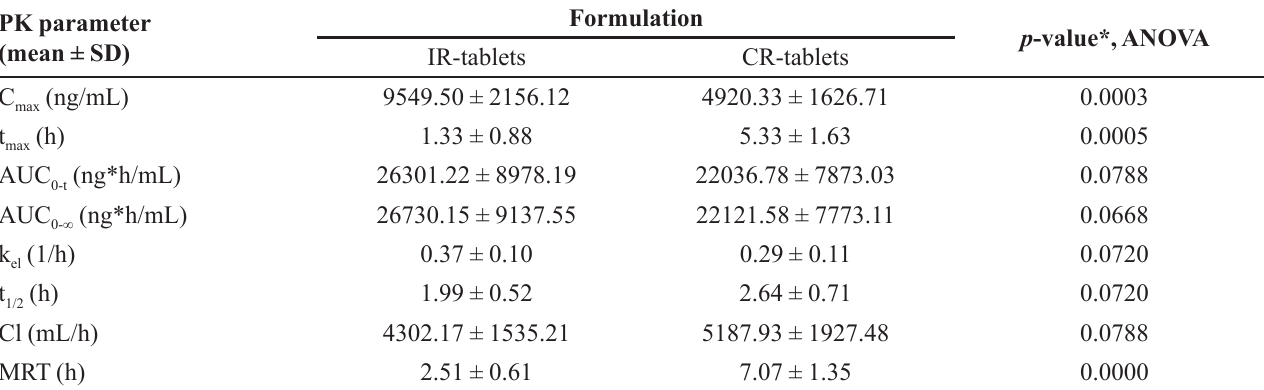
TABLE V – Mean ± SD pharmacokinetic (PK) parameters of ketoprofen in 6 healthy volunteers following the administration of IR-tablets and CR-tablets, respectively